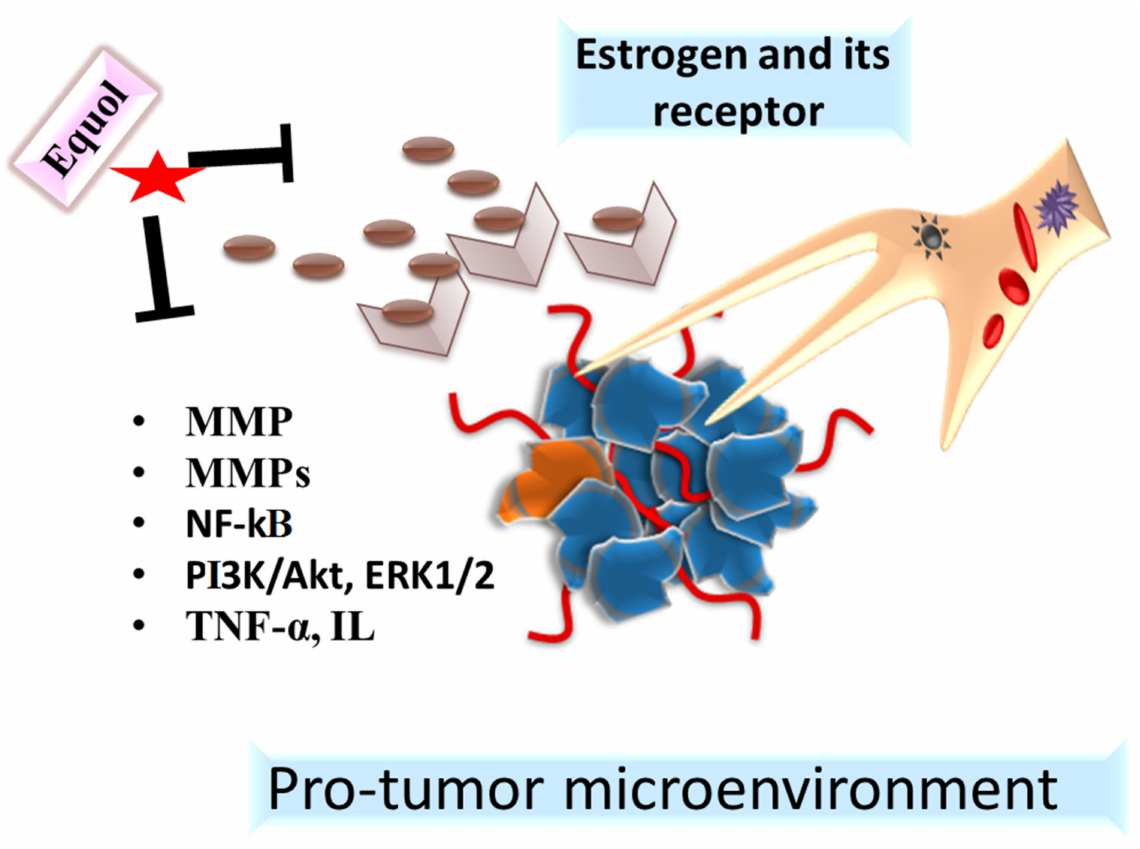
Figure 3. Anticancer action of equol through modulating its binding to estrogen receptors. Red star indicated the